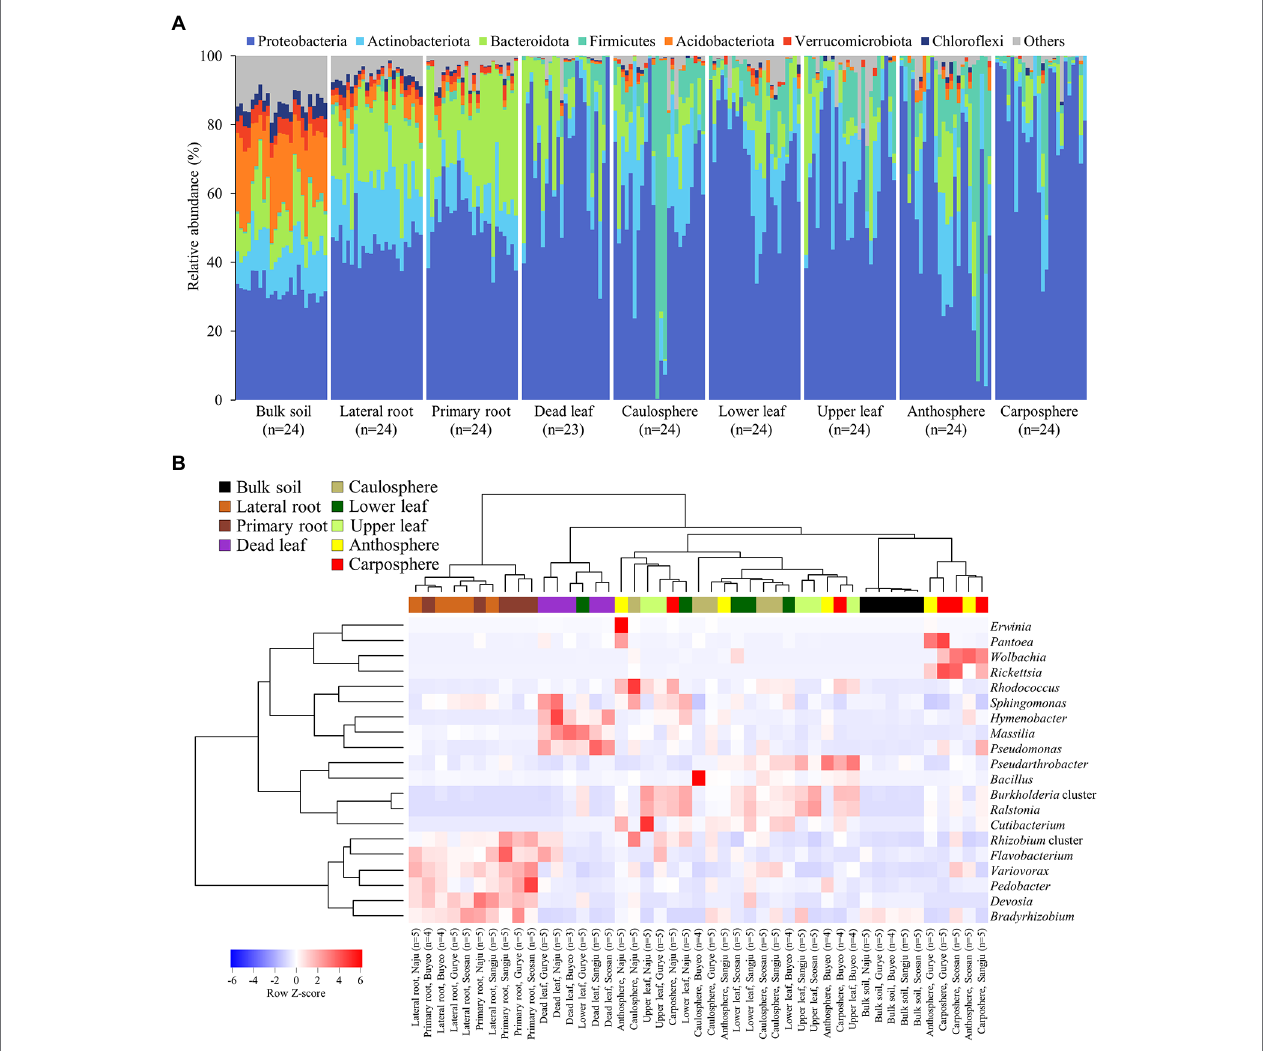
FIGURE 2 | Microbial community composition. (A) Relative abundance of prokaryotic community members at the phylum level. (B) Heatmap of hierarchical clustering of major bacterial groups at the genus level. Dendrograms were calculated using Euclidean distance and the Ward method. Heatmap color (blue to red) displays the row scaled relative abundance (Row Z-score) of each taxon across all samples. The values of the same holobiont components in the same region are averaged. Samples from different holobiont components are displayed according to the color bar above the heat